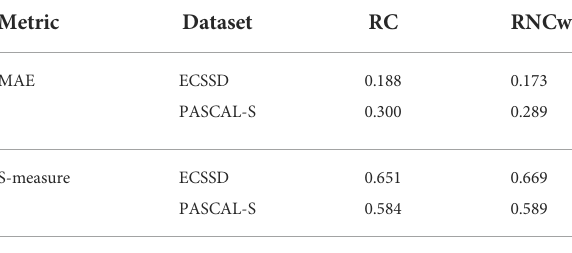
TABLE 1 The S-measure and MAE on two salient object detection datasets. Metric